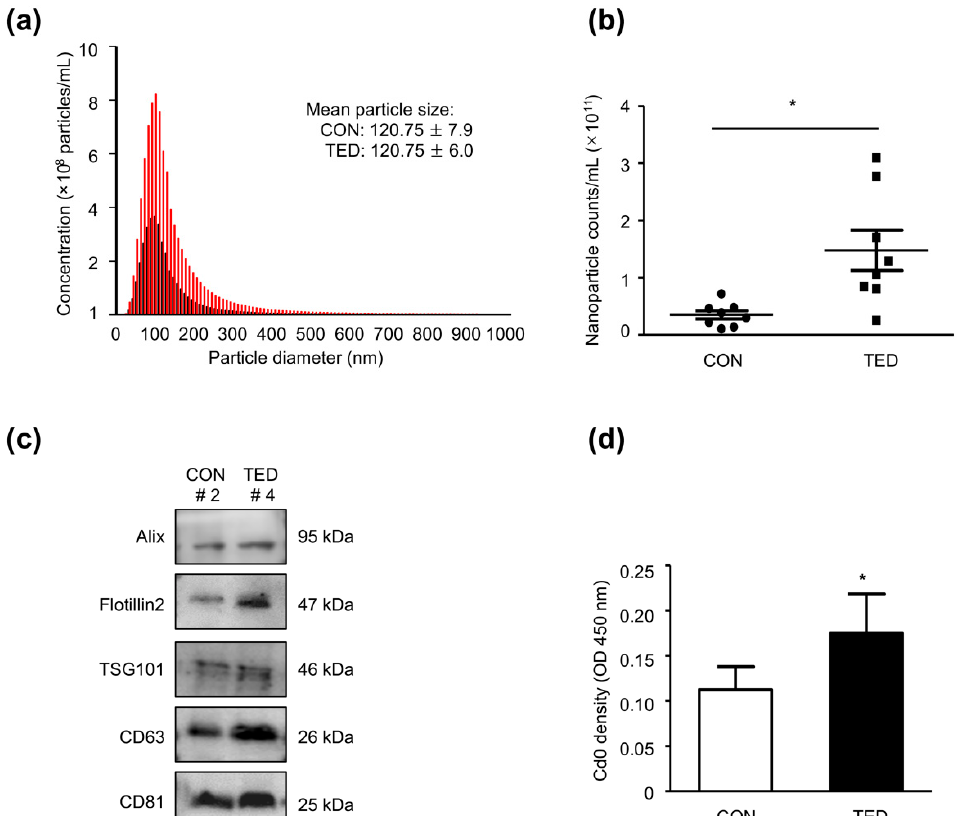
Figure 2. Tear-derived exosomes increased in patients with TED. ( a ) Nanoparticle tracking analysis of exosomes showing the exosome size distributions in the TED group ( n = 8; red line) and the control group ( n = 8; black line). Values are shown as mean ± SD. ( b ) The exosome concentrations increased dramatically in the TED group ( n = 8; black squares) compared to that in the control group ( n = 8; black circles). Statistical differences were determined by performing a paired t -test (* p < 0.05). ( c ) Western blot analysis of exosomes using antibodies against Alix, Flotillin 2, TSG 101, CD 63, and CD 81. The levels of exosome markers were higher in patients with TED than in control subjects. ( d ) Enzyme-linked immunosorbent assay (ELISA) analysis showed higher exosome-contained CD 9 levels in patients with TED ( n = 5; black column) when compared with those of control subjects ( n = 5; white column). Statistical differences were determined using a paired t -test (* p < 0.05). CON—control subject; SD—standard deviation; TED—patient with thyroid eye disease.